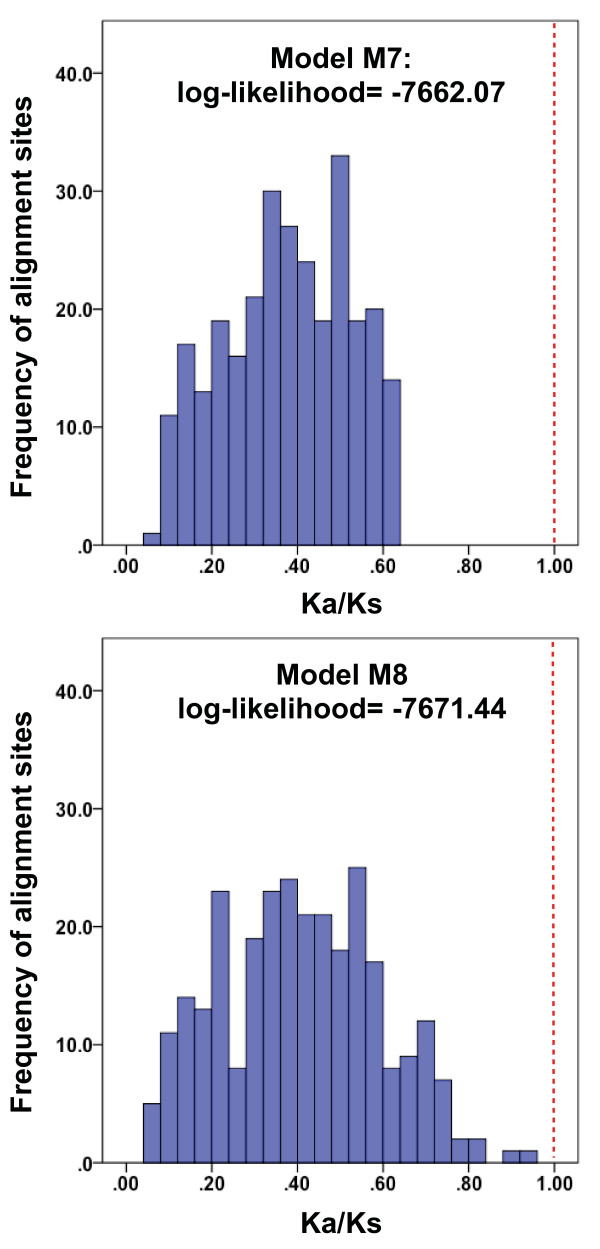
Histograms of Ka/Ks values calculated from alignment sites of the filovirus-like elements in eleven species of mammals. Values are calculated using Bayesian methods and a model that accommodates neutral, positive and negative selection (M8 below), and a model that accommodates largely negative or purifying selection (M7 above). Note the better fit of the purifying selection model. Red dashed lines indicate the expected values under neutral evolution for non-functional pseudogenes, while values <<1 are consistent with purifying selection.